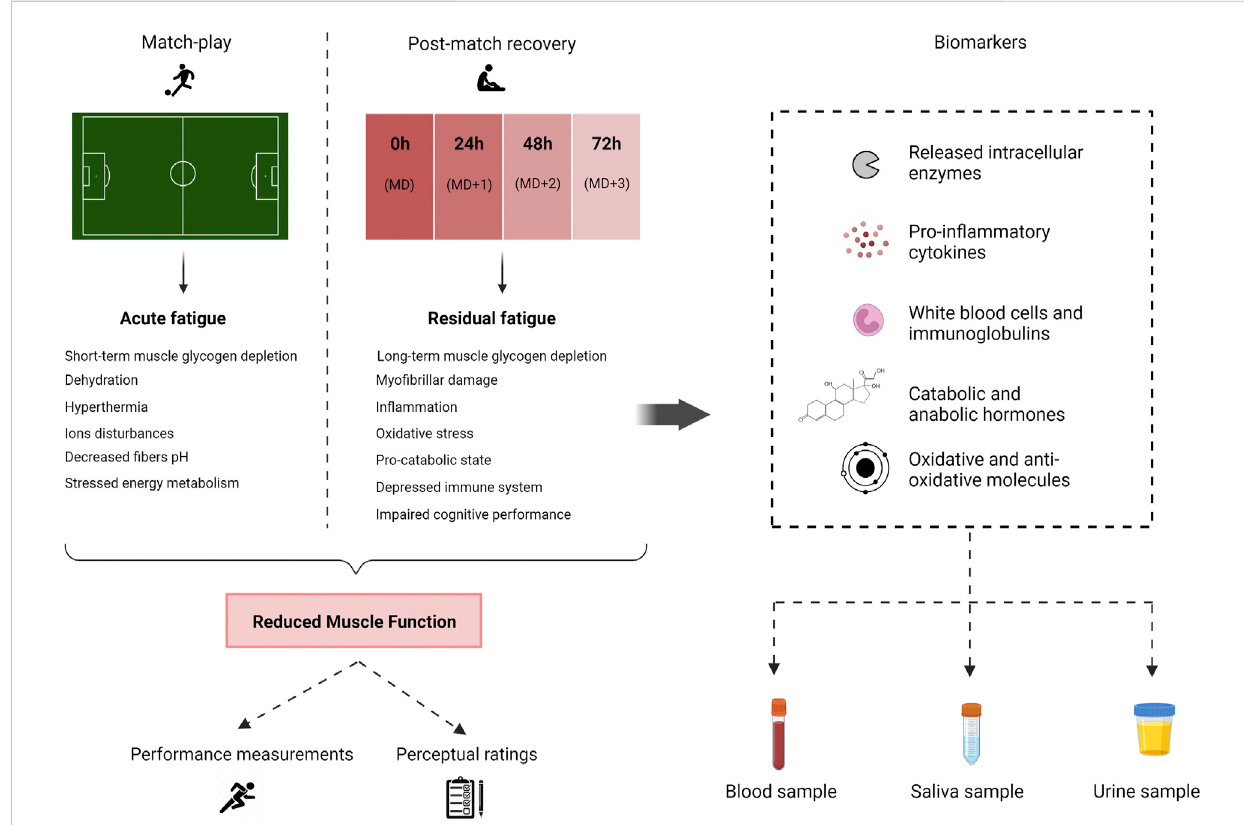
FIGURE 1 Schematic representation of mechanisms of football match-induced fatigue and potential recovery markers. MD,